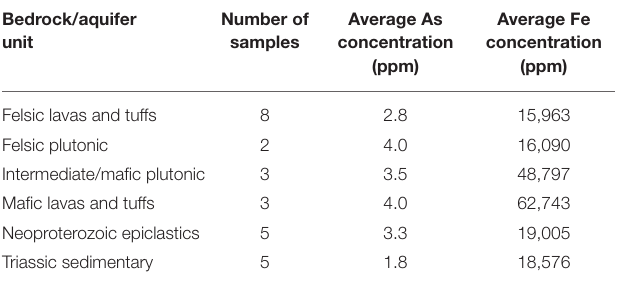
TABLE 2 | The average arsenic and iron concentrations in the bedrock unit samples from the NCGS analyses. Bedrock/aquifer